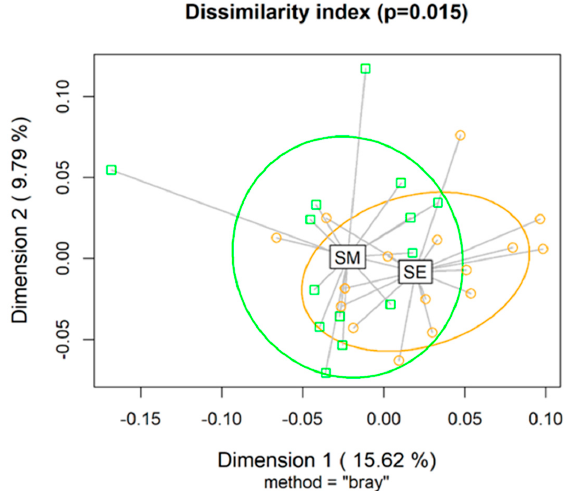
Figure 2. Beta-diversity Bray–Curtis index computed for nonparametric statistical tests between rumen microbial communities of Nellore cattle grazing Urochloa brizantha cv. Marandu and supplemented with energy supplements (SEs) or mineral supplements (SMs). There were no observed effects of the addition of a phytogenic compound blend containing 10% of carvacrol and cinnamaldehyde oil, and 90% hydrolyzable tannins extracted from berries and grapes at a dose of 1.5 g/kg of ingested dry